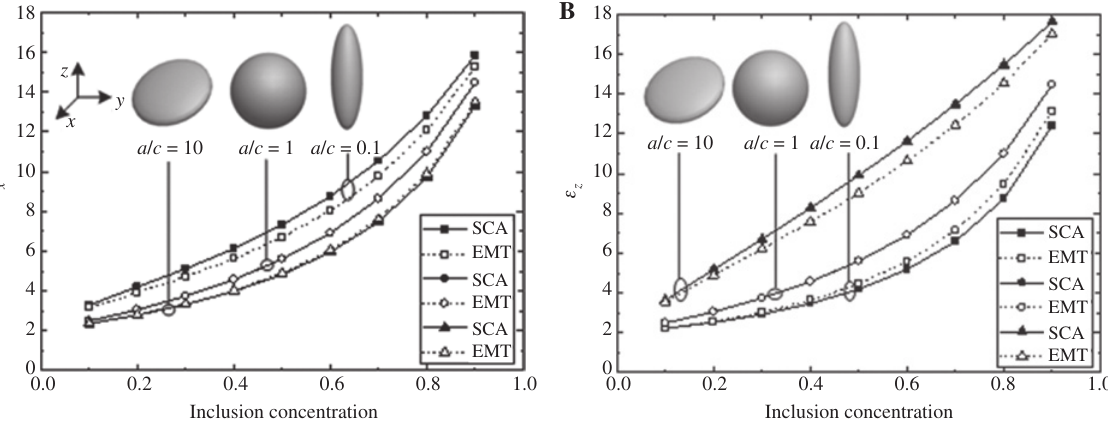
Figure 7: The effective permittivity of mixtures with aligned uniphase ellipsoids in the x direction (A) and z direction (B) is calculated by the SCA method (solid line) and the EMT formula (dash line) for different inclusion concentrations. The permittivity of inclusions is 20 and that of the host matrix is